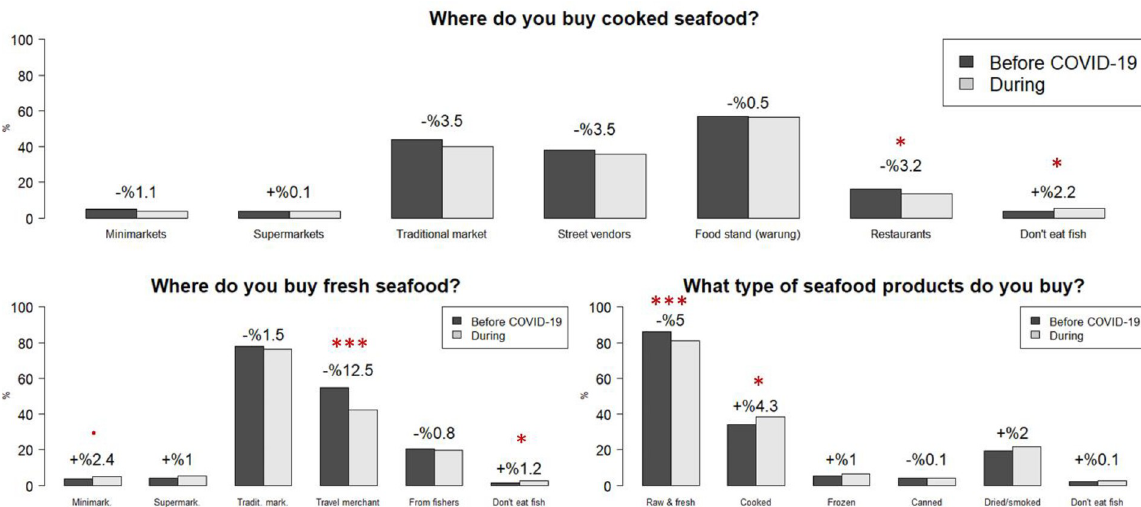
Fig 2. Where cooked seafood is accessed and purchased, before and during the pandemic (top). Where fresh/raw seafood is accessed and purchased (bottom left). The types of seafood products purchased (bottom right). Percentages indicate change during COVID-19. Red stars indicate the significance level of two-proportion z-tests conducted on the response changes between the two periods. Significance codes: < 0.001 ‘ ��� ’ < 0.01 ‘ �� ’ < 0.05 ‘ � ’ < 0.1 ‘.’ Full response results are in the S4 Table in S1 File.